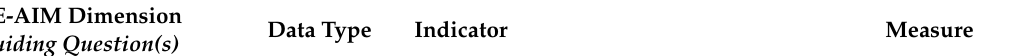
Table 1. RE-AIM QuEST dimensions with quantitative and qualitative indicators and measures (table adapted from